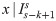
APE prediction accuracy.We compare the APE metric (blue, left y axes) to the percentage of true incidence values, Is+1 that fall outside the 95% prediction intervals of x|Is-k+1s (red, right y axes) for various window sizes k. The dashed line is k*. Panels correspond to those of Figs 2 and 3.